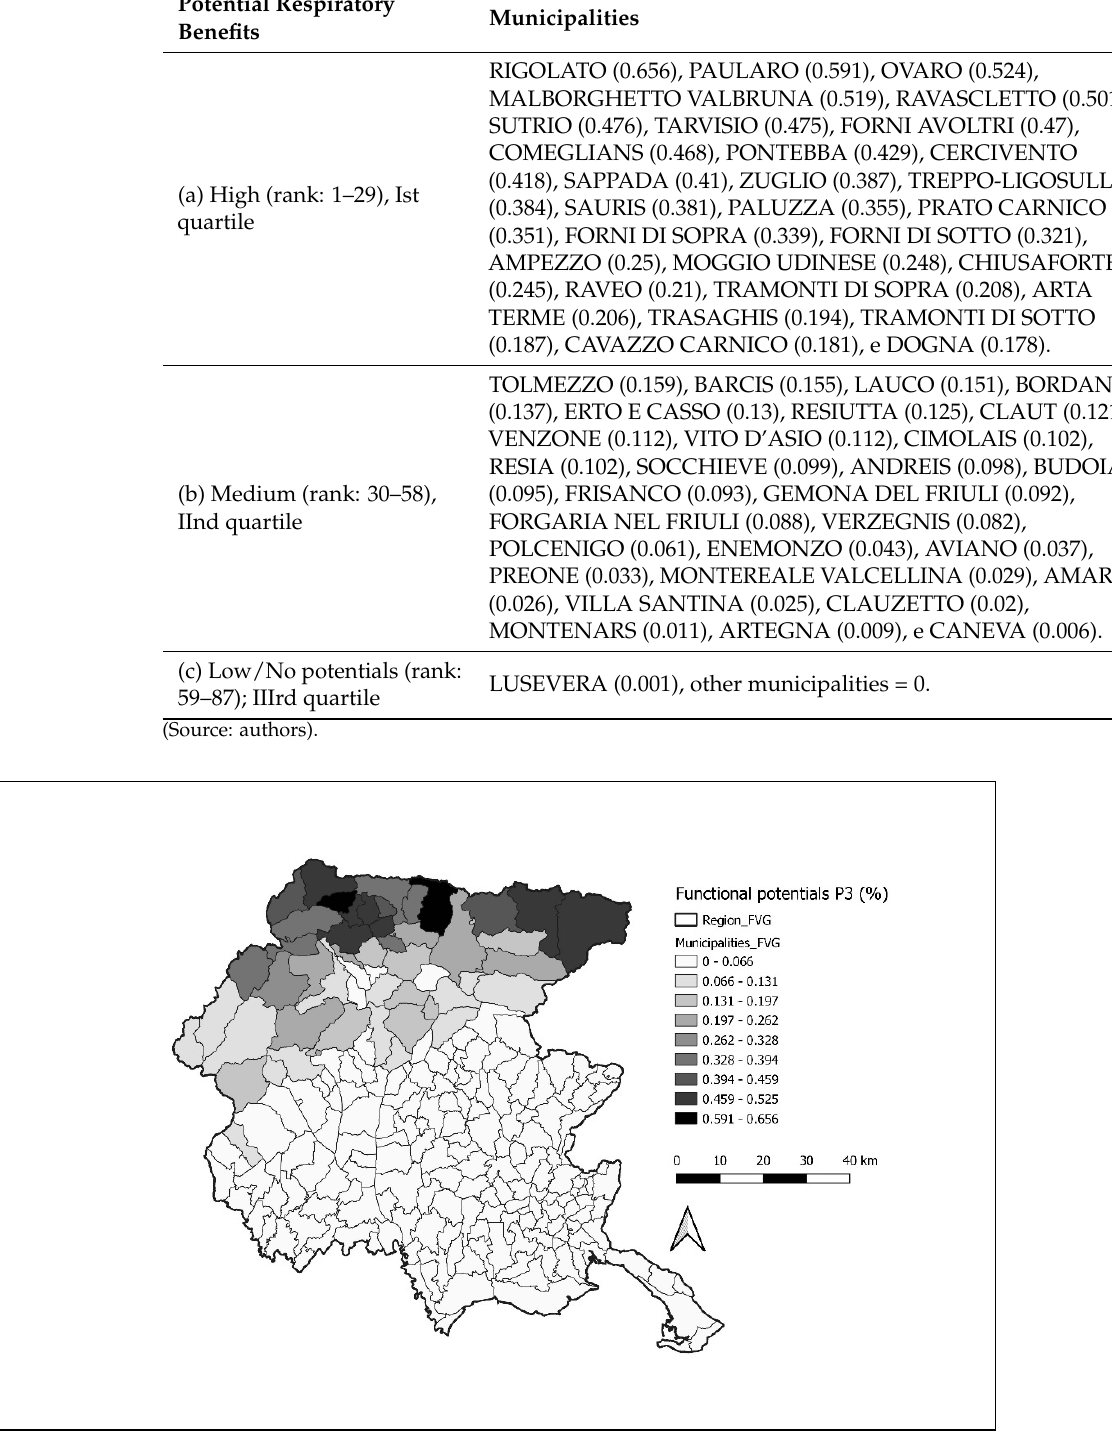
Figure 7. Potential respiratory benefits of BVOCs emitted by regional forests in mountain municipalities: Dynamic-relational approach (P3). Source: authors.